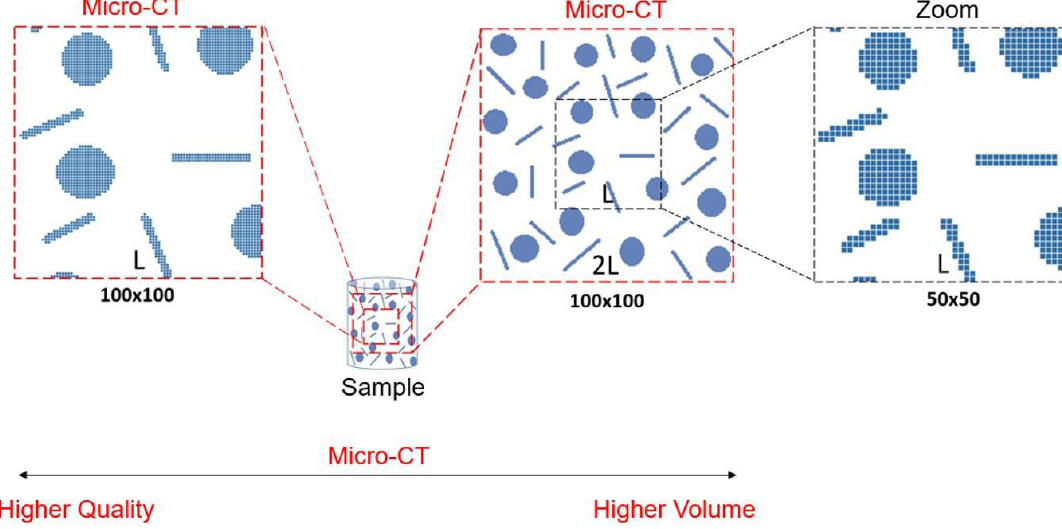
Figure 2. Relation between image quality and size of ROI for a micro-CT image with fixed number of voxels. In the left, a small region can be digitalized with small voxels obtaining a good quality to represent the details. On the other hand, the image on the right represents a bigger region with bigger voxels resulting in lower